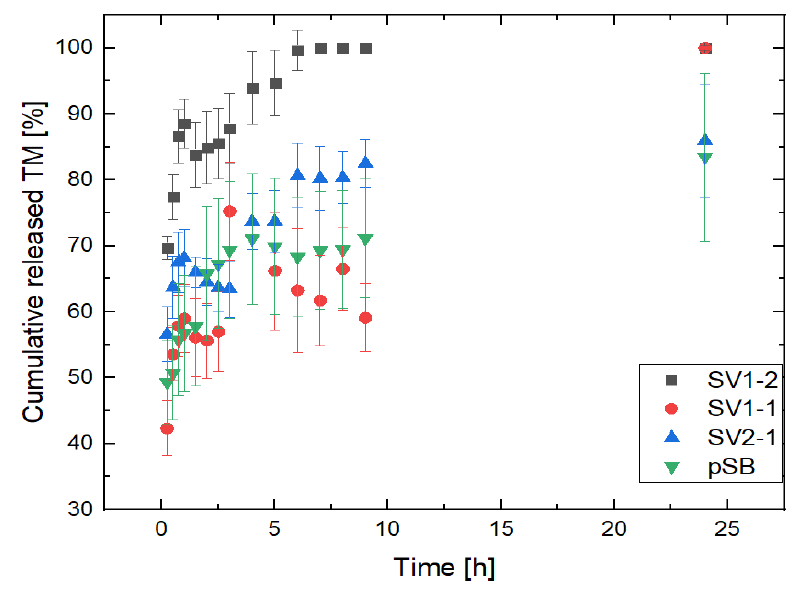
Figure 3. Release profiles of TM from the copolymeric hydrogels for 24 h.